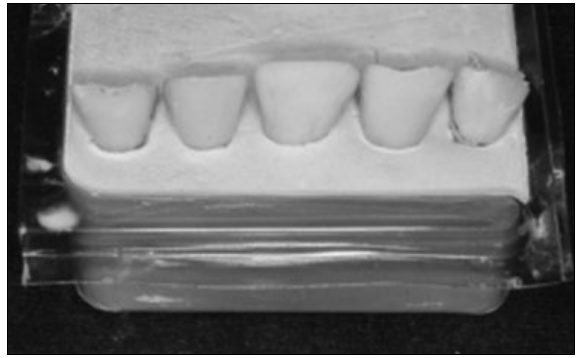
Figure 1. Bovine teeth embedded in dental plaster. Figure 2. Plaster models for indirect bonding.